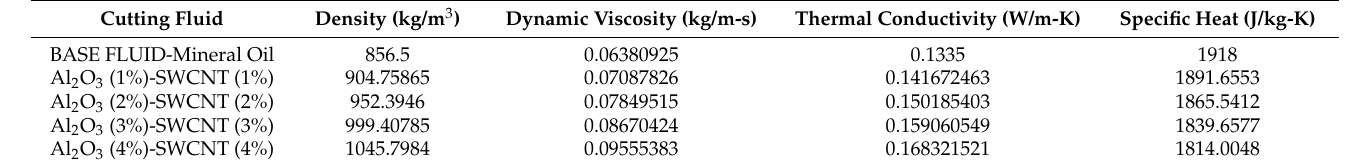
Table 4. Thermophysical and mechanical properties of mineral oil dispersed with Al 2 O 3 -SWCNT.